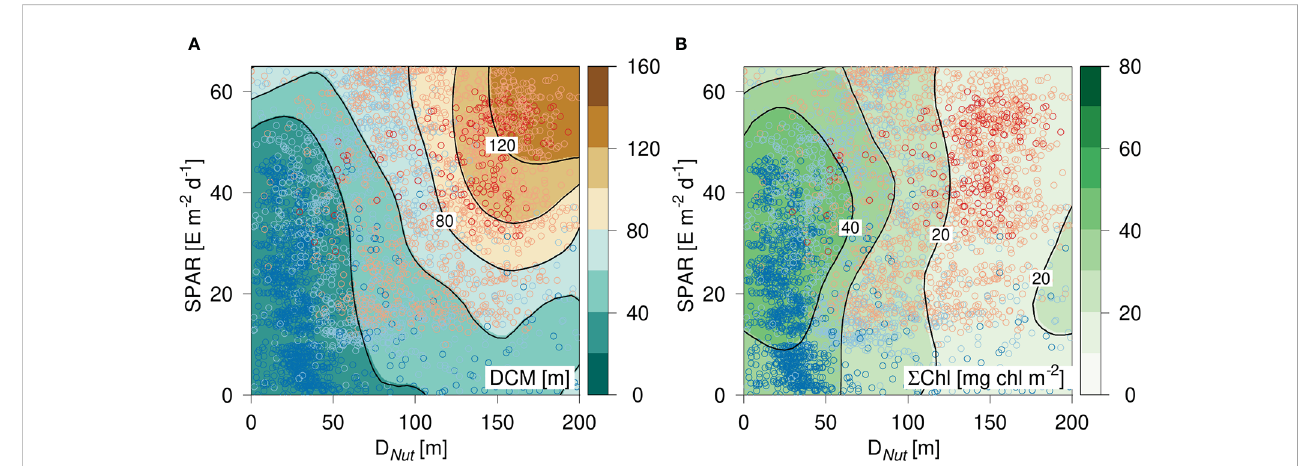
FIGURE 3 Diagram of (A) DCM and (B) vertically integrated chlorophyll ( S Chl) versus the corresponding nutricline depth (D Nut ) calculated from Argo-pro fi les and daily averaged Photosynthetic Available Radiation at the surface (SPAR) obtained from satellite observations. Color shading of the circles shows the latitude of the corresponding pro fi le (see Figure 2).